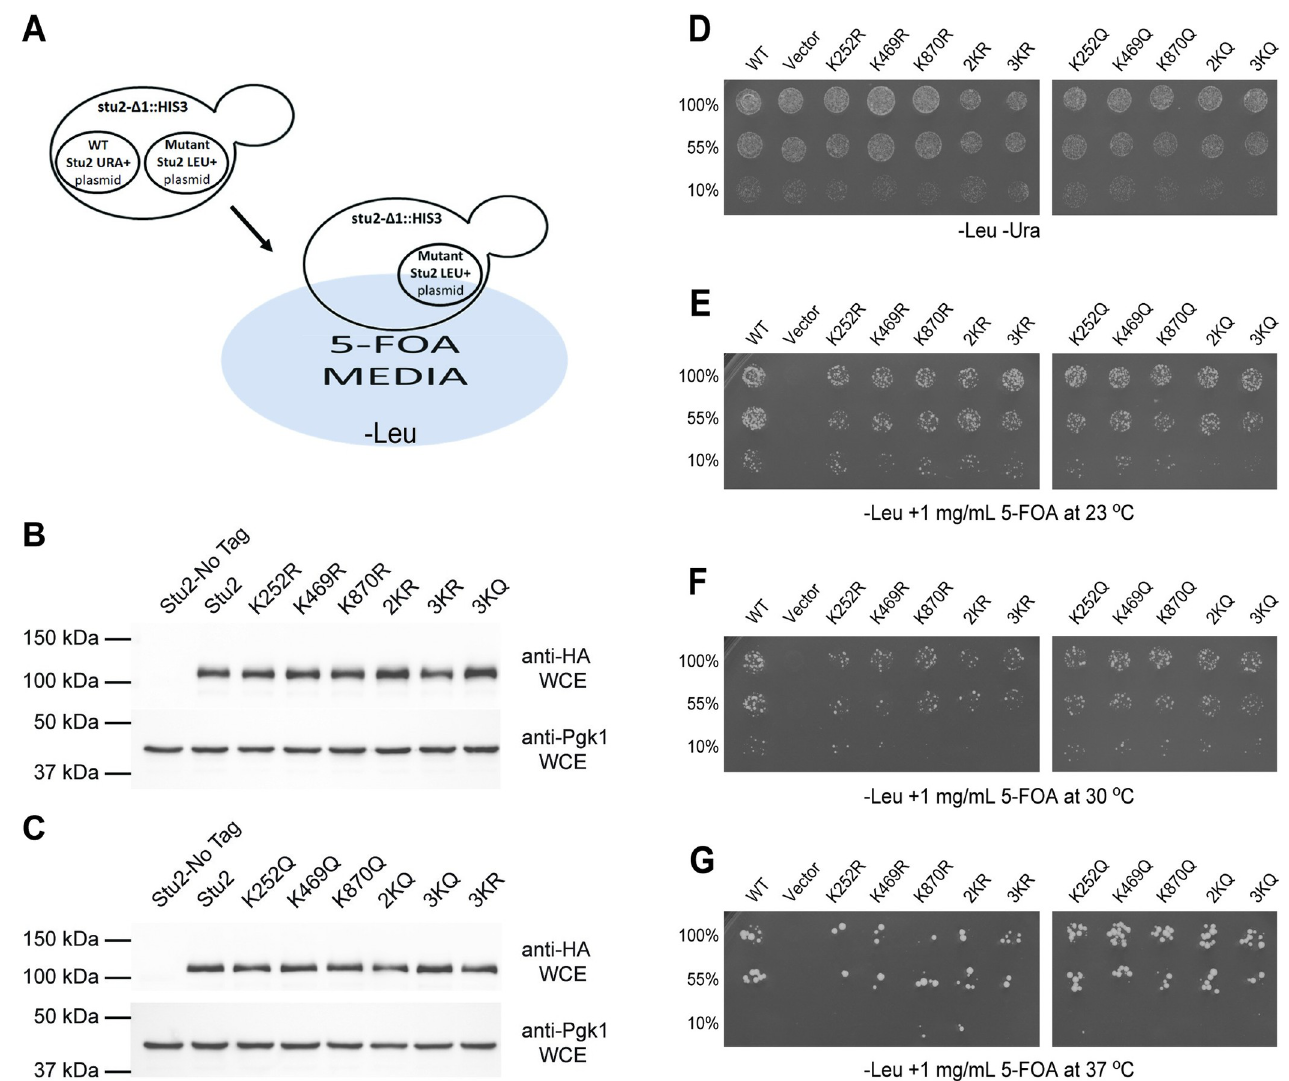
Fig 5. Plasmid-shuffle complementation assays demonstrate Stu2 acetyl-state mutants are functional. (A) A plasmid shuffle assay was used to detect phenotypes from acetyl-lysine mimicking (K-to-R) and inhibitory (K-to-Q) mutations in a strain deleted for STU2 (yRM12321). As STU2 is an essential gene, viability was supported using a URA3 plasmid containing STU2 (pRM10693). Yeast strains also contained LEU2 plasmids with WT- STU2 (yRM12337), LEU2+ empty vector (yRM12338), Stu2-K252R (yRM12340), Stu2-K469R (12341), Stu2-K870R (12342), Stu2-2KR (yRM12343), Stu2-3KR (yRM12344), Stu2-K252Q (yRM12345), Stu2-K469Q (yRM12346), Stu2-K870Q (yRM12347), Stu2-2KQ (yRM12348), and Stu2-3KQ (yRM12349). (B, C) Following 5-FOA selection, WCEs from yeast expressing untagged Stu2 (yRM12359), Stu2-HA (yRM12358), K252R (yRM12360), K469R (12361), K870R (12362), 2KR (yRM12363), 3KR (yRM12364), K252Q (yRM12365), K469Q (yRM12366), K870Q (yRM12367), 2KQ (yRM12368), and 3KQ (yRM12369) were western blotted with anti-HA to detect relative abundances of Stu2 mutants relative to the WT control. (D-G) To assess the ability of the mutants to complement at a range of temperatures, the strains possessing WT and mutants copies of Stu2 were also transferred to plates lacking leucine and uracil and grown at 30˚C (D) or leucine deficient 5-FOA plates and incubated at 23˚C (E), 30˚C (F), and 37˚C. (G).